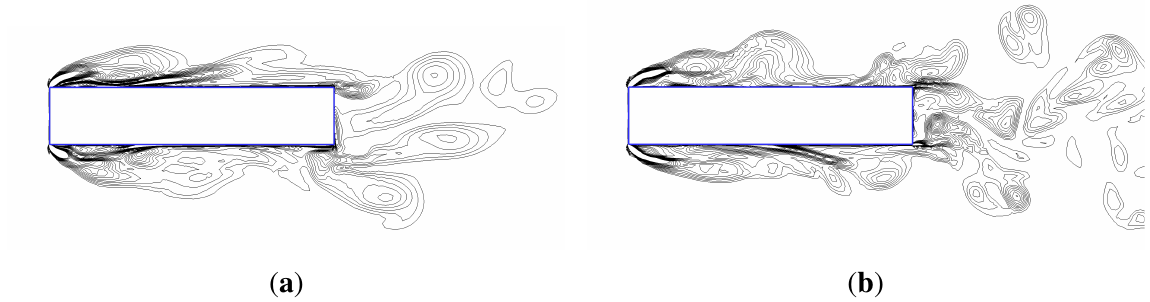
Figure 11. Vorticity magnitude isocontours for the rectangular 5:1 cylinder: ( a ) DES-SA = 1 / 64 and number of inner iterations per physical time step (NITER) = 100; SD-div with k 4 = 1 / 84 and NITER = ( b ) DDES-SA MD-skew with k 4